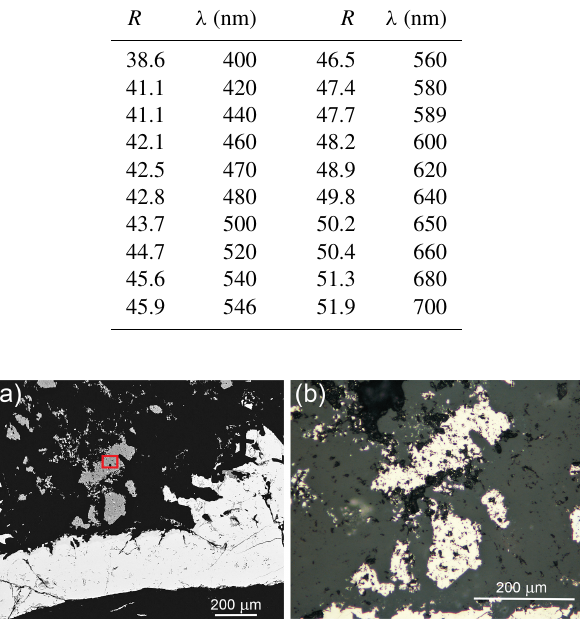
Figure 1. (a) Hypidiomorphic grains of grimmite (grey) closely as- sociated with minerals of the skutterudite group (skutterudite and ferroskutterudite) with a thin nickeline rim (all white). BSE photo: the area of extracted fragment for single-crystal study is outlined in red; (b) reflected light photo, partly crossed polarisers.